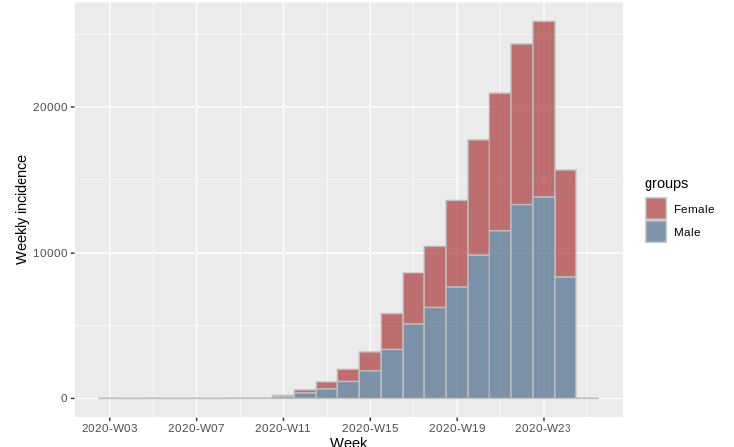
Figure 8. Weekly incidence plot of cases of SARS-CoV-2 in the population from all the